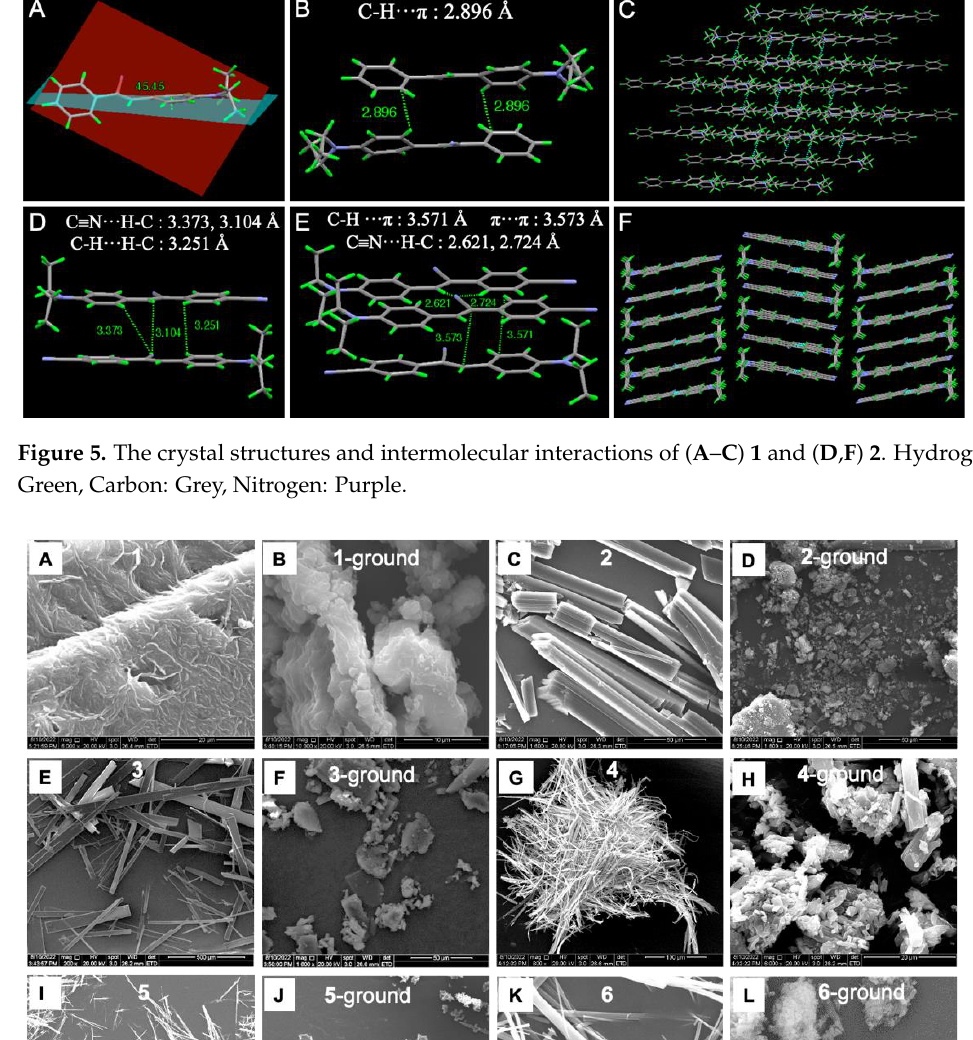
Figure 5. The crystal structures and intermolecular interactions of ( A – C ) 1 and ( D , F ) 2. Hydrogen: Green, Carbon: Grey, Nitrogen: Purple.